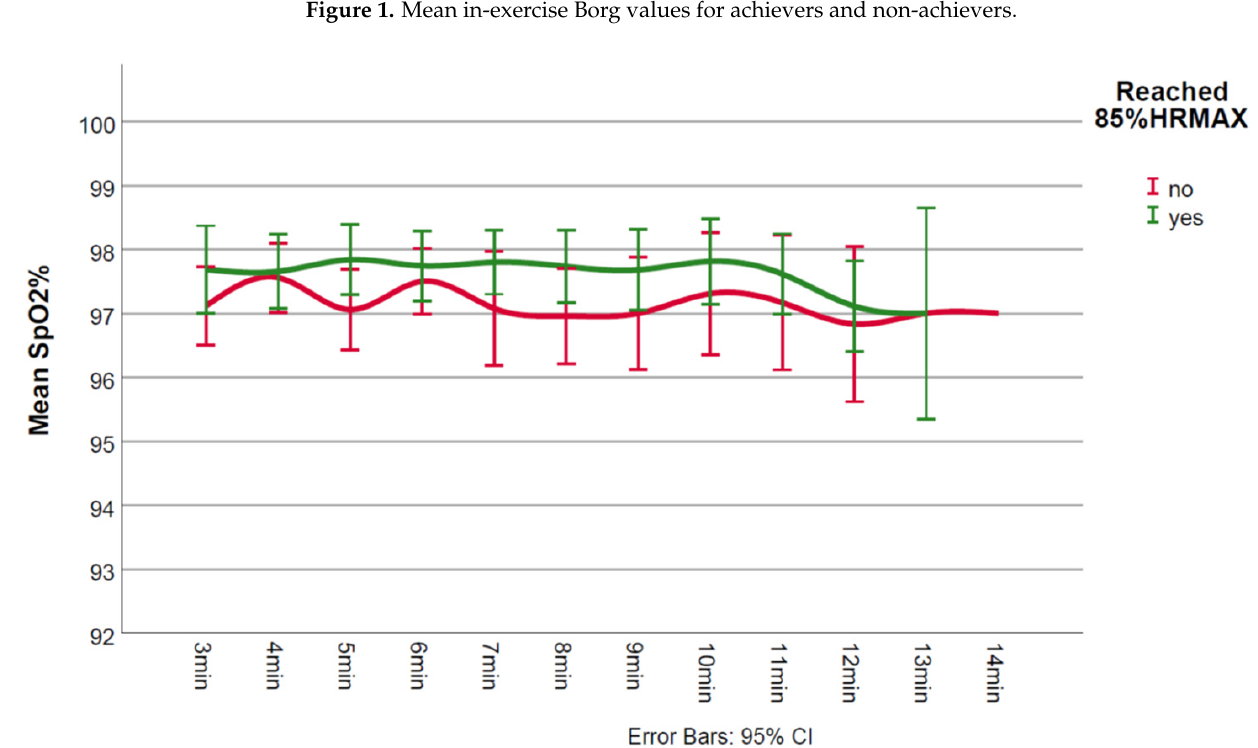
Figure 2. Mean in-exercise SpO 2 % values for achievers and non-achievers.